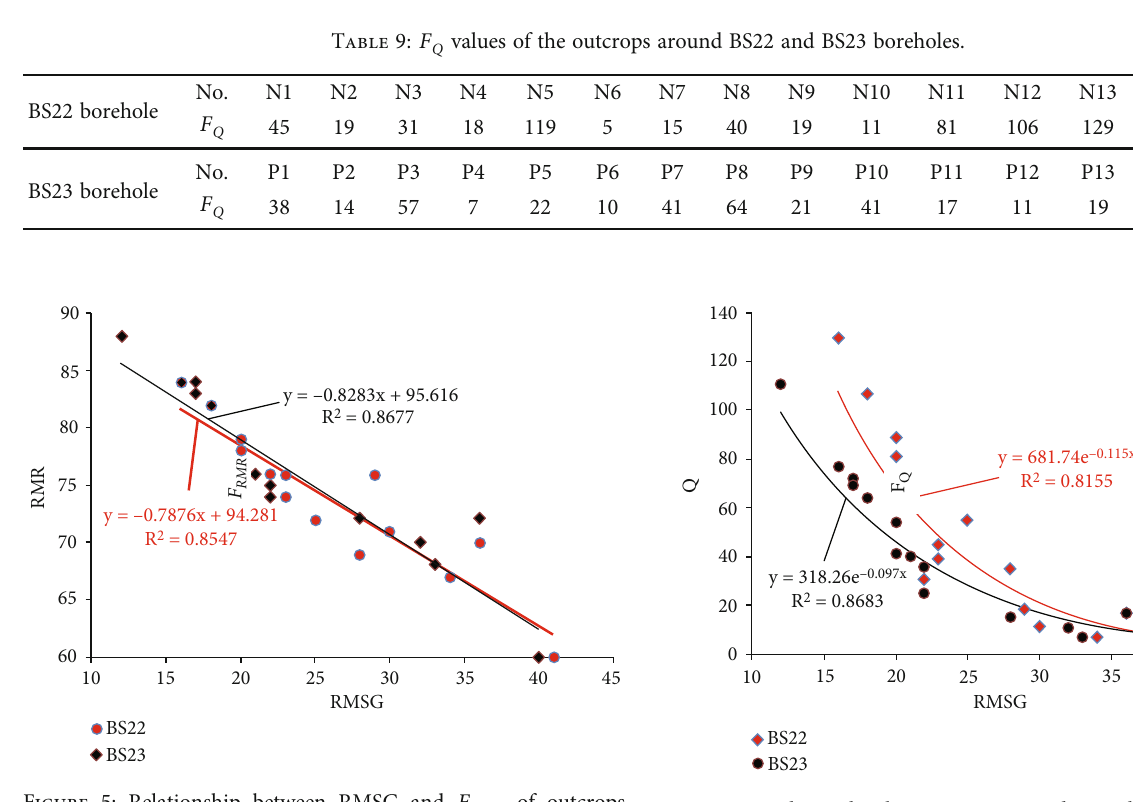
Q values of outcrops